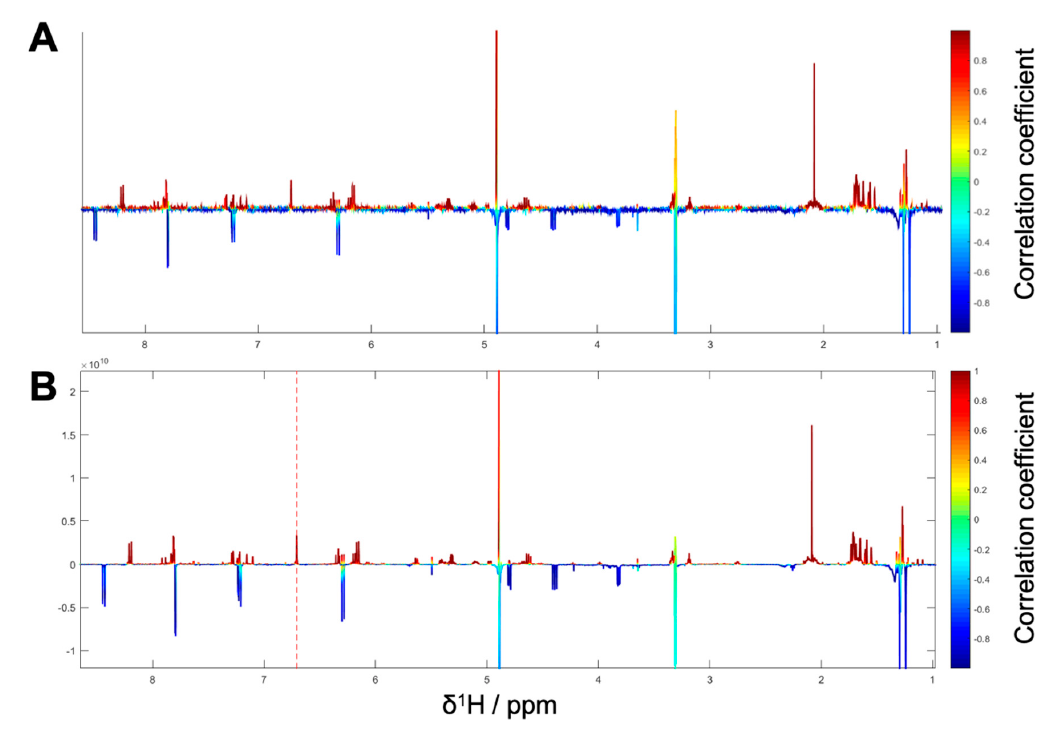
Figure 7. ( A ) 1 H NMR pseudo-spectrum showing the HetCA of 1 H NMR spectra and NF-kB reporter- gene assay of selected fractions PO01_27–PO01_29 (i.e., package V); ( B ) STOCSY plot of package V. The signal at δ H 6.71 was chosen to obtain the information which molecule(s) share this hot feature.